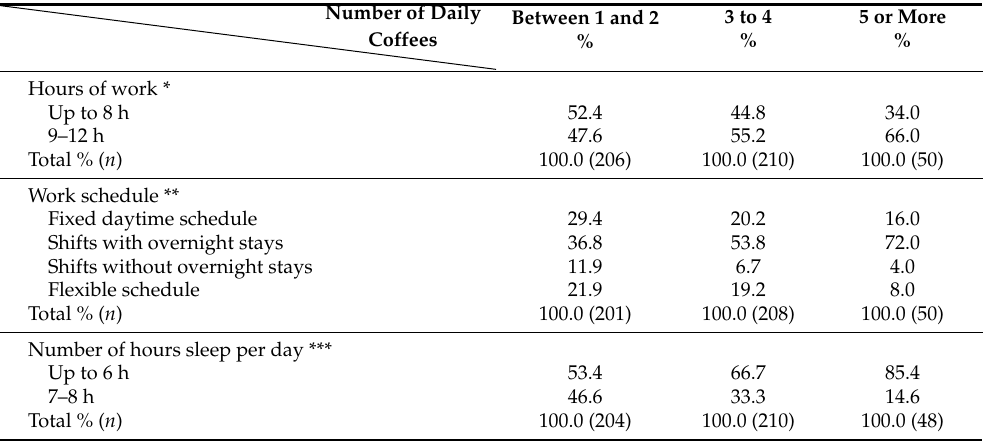
Table 6. Number of cups of coffee per day, by number of hours of work per day, work schedule, and number of hours of sleep per day on working